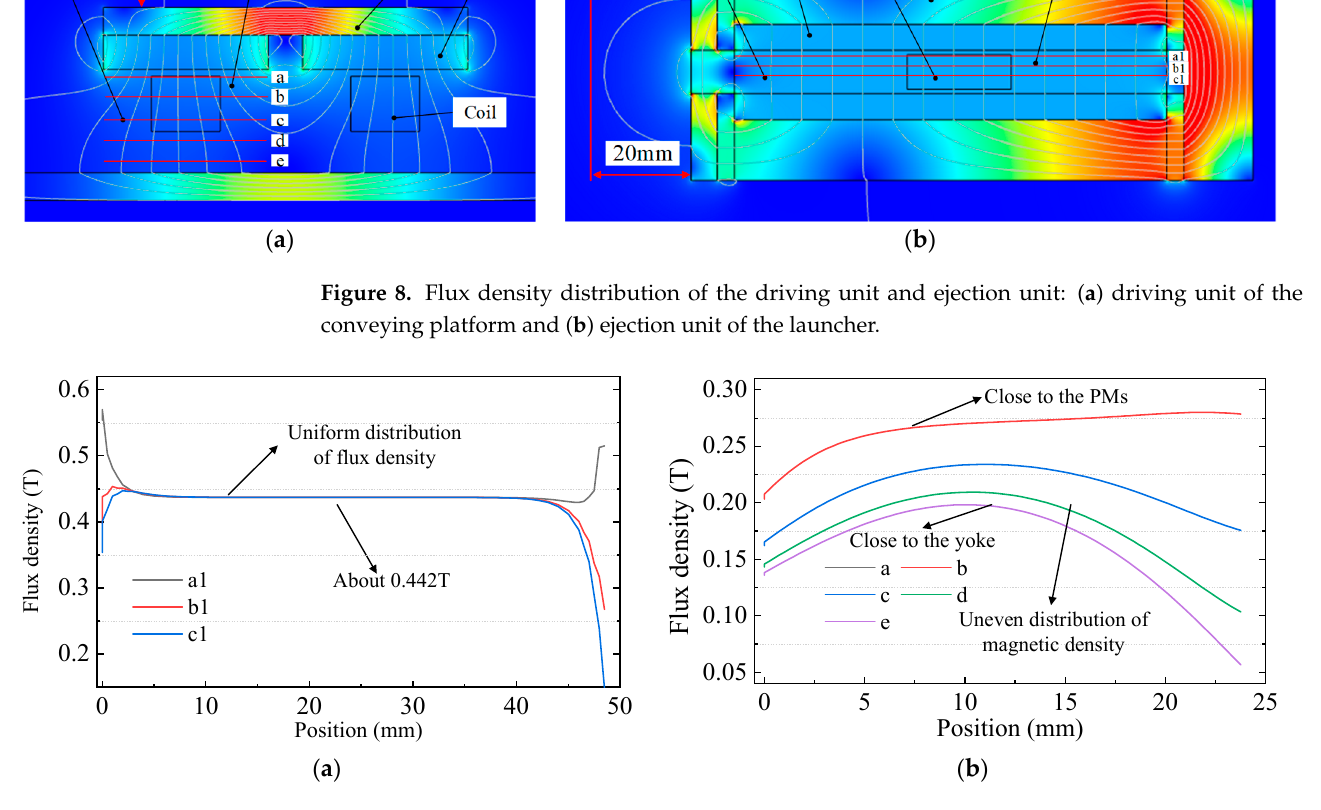
Figure 9. Flux density in the airgap region: ( a ) driving unit of the conveying platform and ( b ) ejection unit of the launcher.